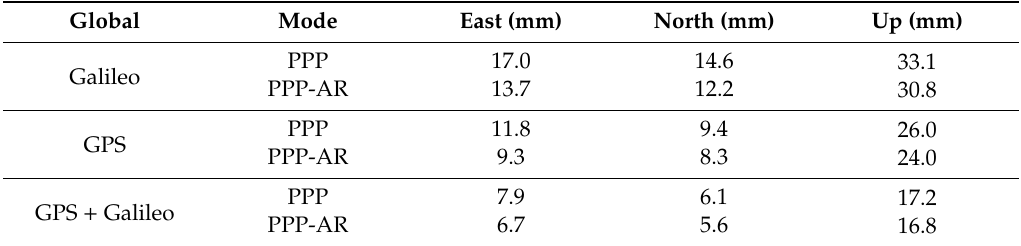
Table 8. Global RMS of 1- σ values for PPP and PPP-AR for the entire network examined. Global Mode East (mm) North (mm) Up (mm) PPP 17.0 14.6 33.1 Galileo PPP-AR 13.7 12.2 30.8 PPP 11.8 9.4 26.0 GPS PPP-AR 9.3 8.3 24.0 PPP 7.9 6.1 17.2 GPS + Galileo PPP-AR 6.7 5.6